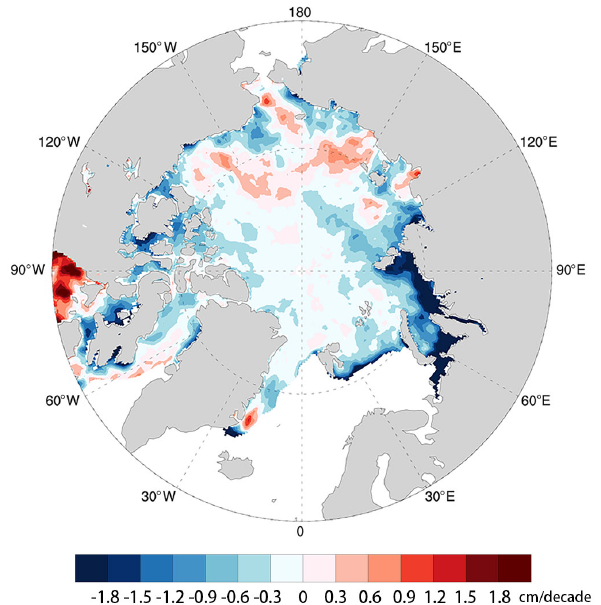
Figure 7. The interdecadal trends in snow depth on sea ice induced by the precipitation phase transition in the early melt season during 1980–2017 based on